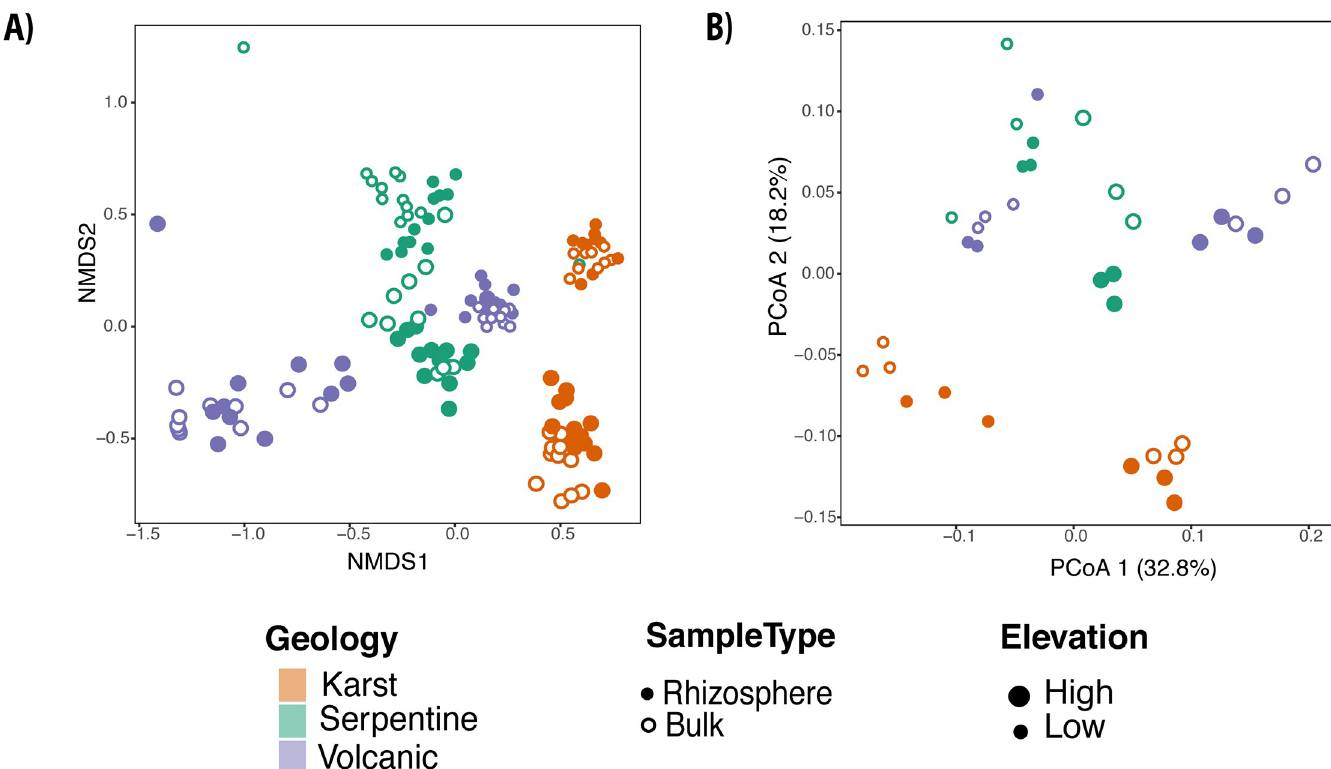
Fig 3. Beta diversity plots. Panel A shows nMDS ordination based on the relative dissimilarities of the 137 samples (Bray Curtis) (stress 0.1232491) representing each parent material and elevation along with microhabitat. The Principal coordinates of panel B, corresponding to the collapsed sample units n = 36, demonstrate that primary clustering is by geology and elevation, mainly separating the Karst samples from the rest of the parent materials as shown also in the nMDS plot.